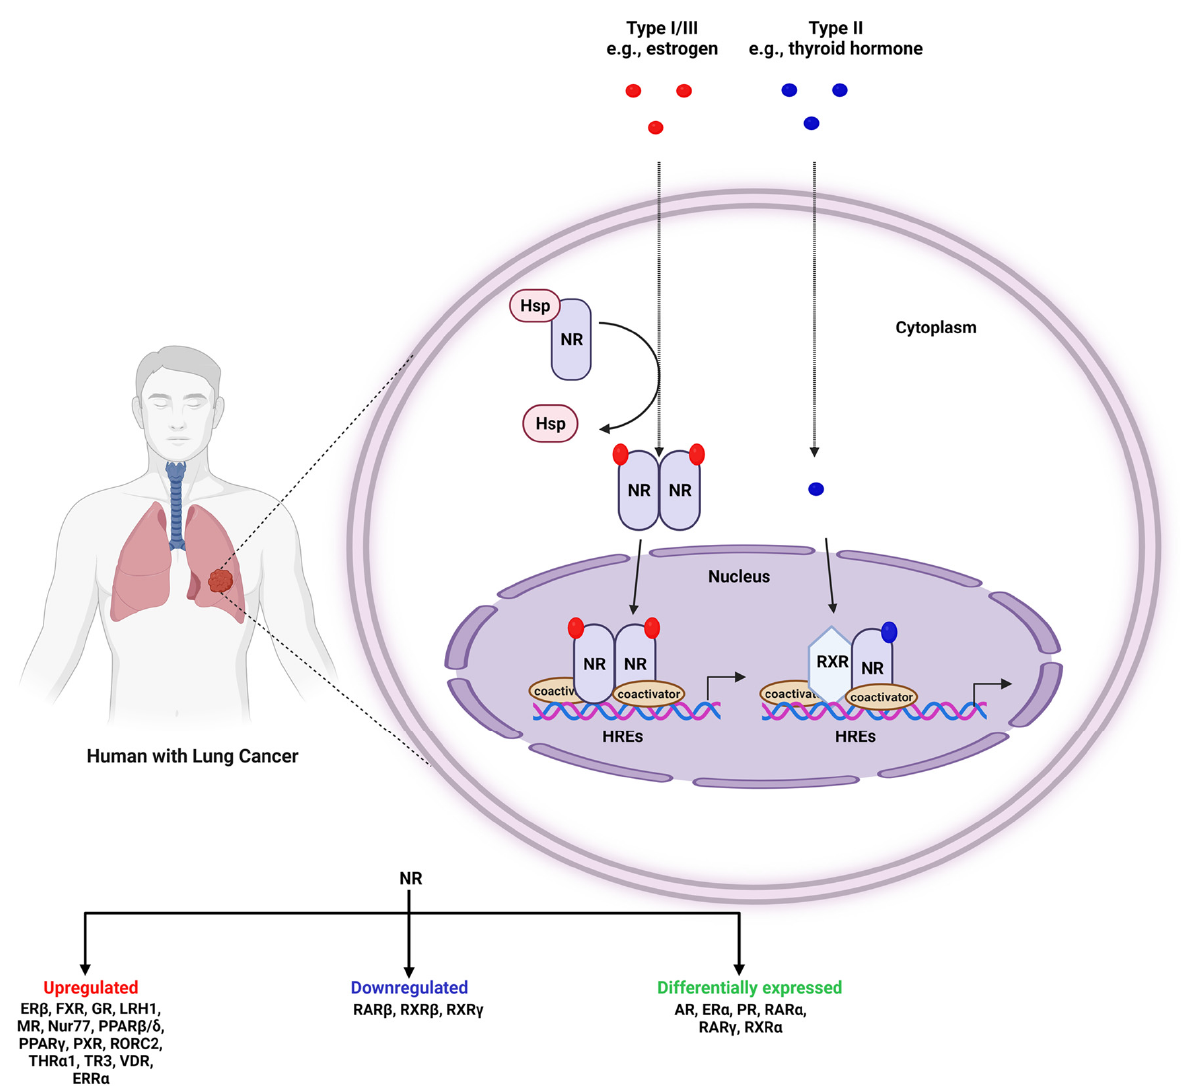
Figure 1. NRs involved in lung tumorigenesis. There are four major types of NRs: Type I/III receptors bind with the ligands in the cytoplasm, leading to their dissociation from the chaperons and subsequent nuclear translocation and transcription of active genes; in contrast, Type II receptors dimerize with the other NRs, and dissociate the corepressor through ligand binding, activating the NRs. Numerous studies have shown differential expression of various NRs in lung